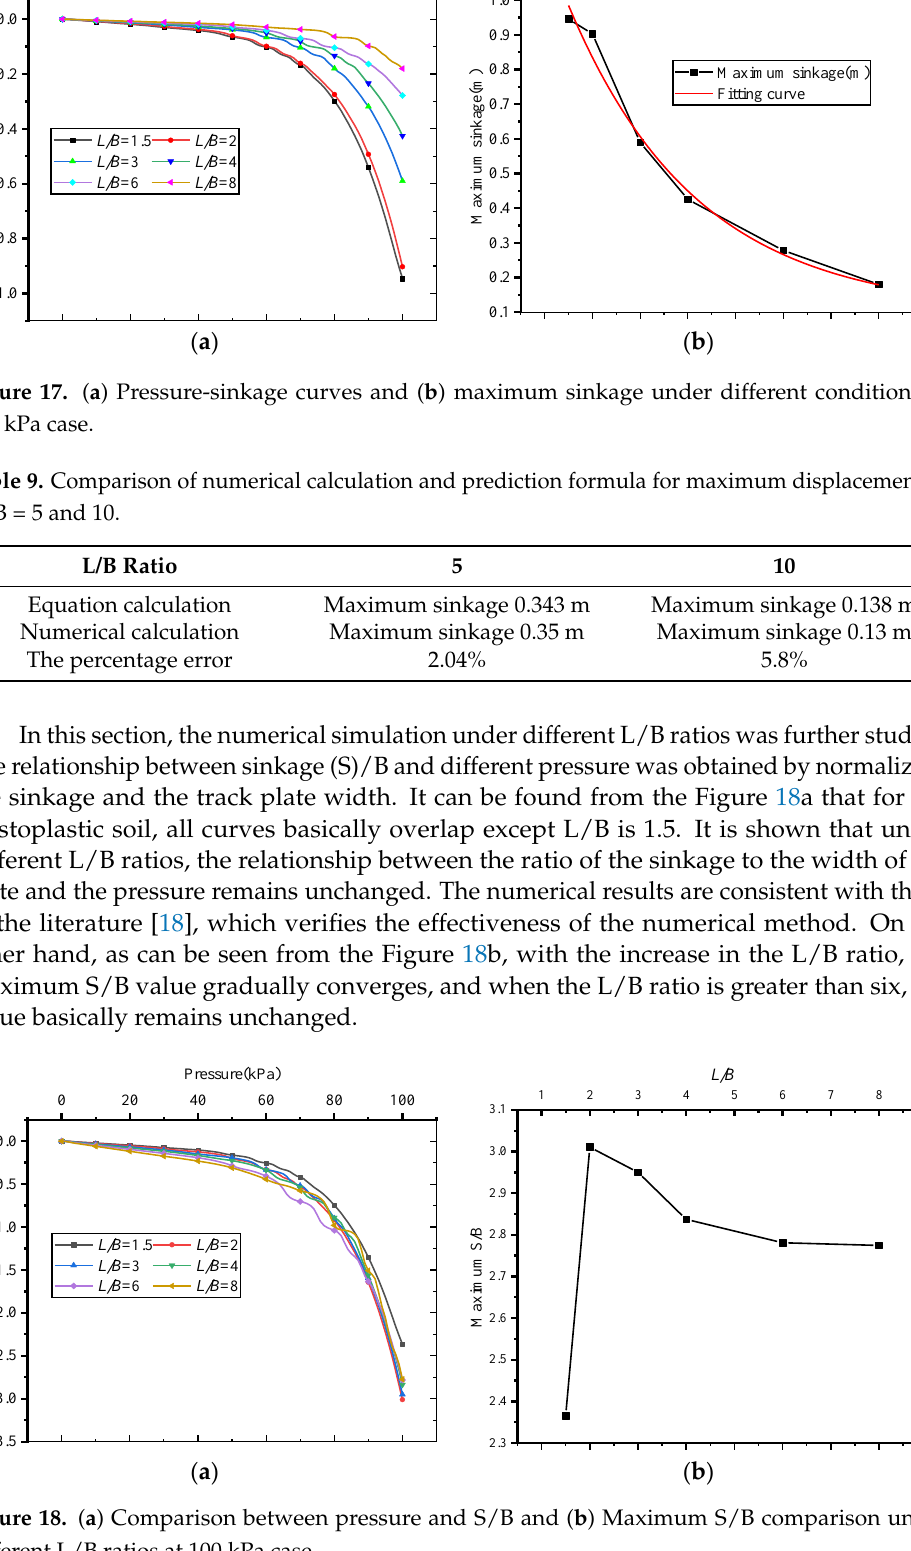
ferent L/B ratios at 100 kPa case.